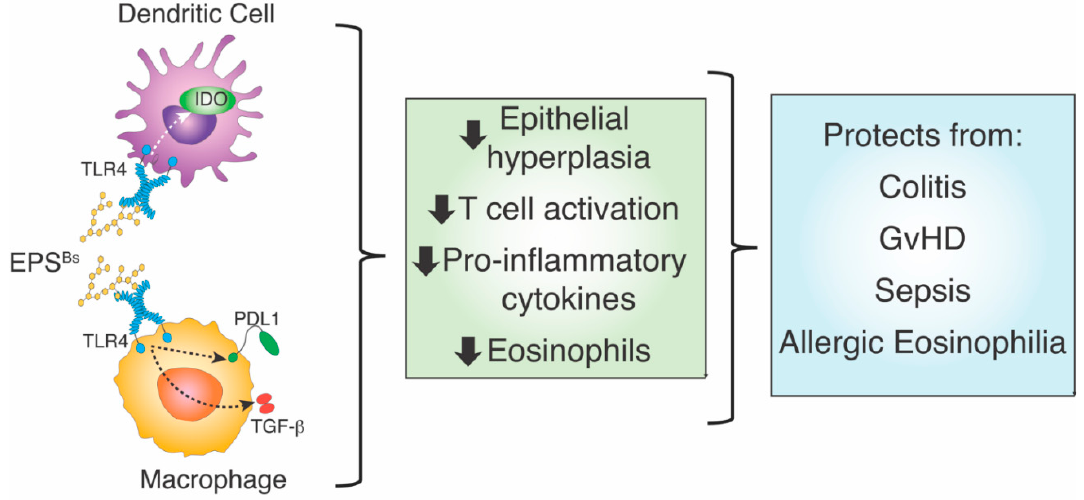
Figure 3. Summary of cellular and molecular effects of EPS Bs on disease-induced inflammatory pro-cesses.